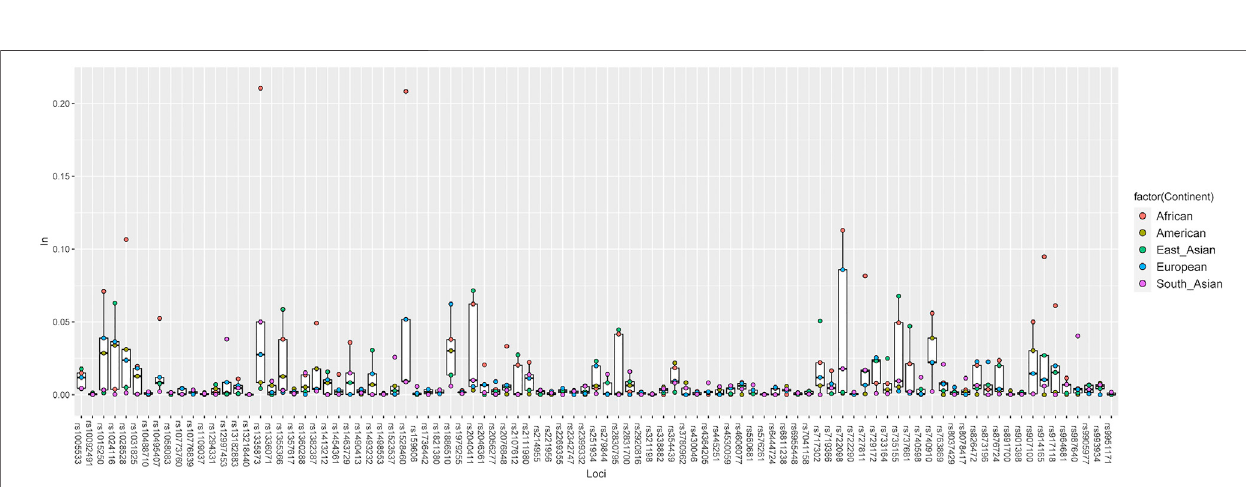
Frontiers in Genetics |